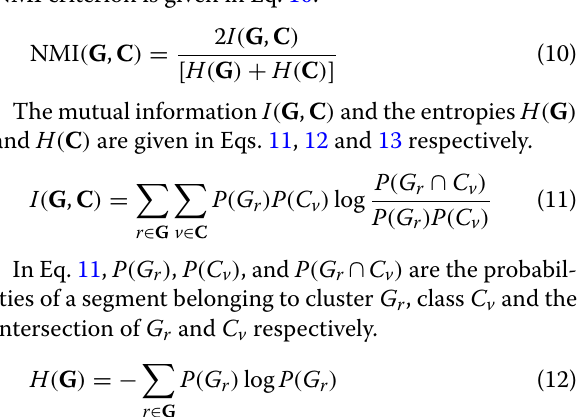
measure cluster and class cohesiveness respectively. The NMI criterion is given in Eq.